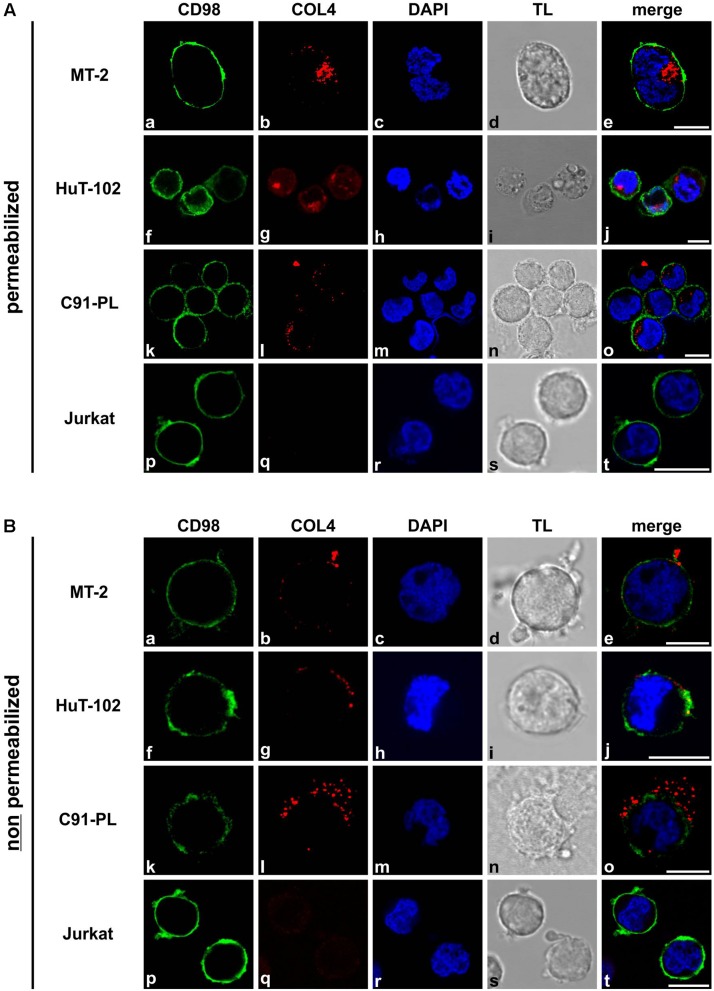
COL4 protein localizes to extra- and intracellular compartments in HTLV-1 positive T-cells. (A,B) Immunofluorescence staining was performed in the HTLV-1 positive T-cell lines MT-2, HuT-102 and C91-PL and in the HTLV-1 negative T-cell line Jurkat. Cells were spotted on epoxy-resin coated glass slides. The plasma membrane was visualized in green by using a mouse primary antibody against CD98, together with the secondary antibody anti-mouse Alexa Fluor® 488. COL4 protein was depicted in red, employing a COL4 targeting rabbit primary antibody that was recognized by the secondary antibody anti-rabbit Alexa Fluor® 647. DAPI staining of nuclei (blue) and transmitted light (TL) served as controls. Cells in (Aa–t) were permeabilized before antibody treatment, cells in (Ba–t) were left without permeabilization showing extracellular COL4 protein only. The scale bars represent 10 μm.